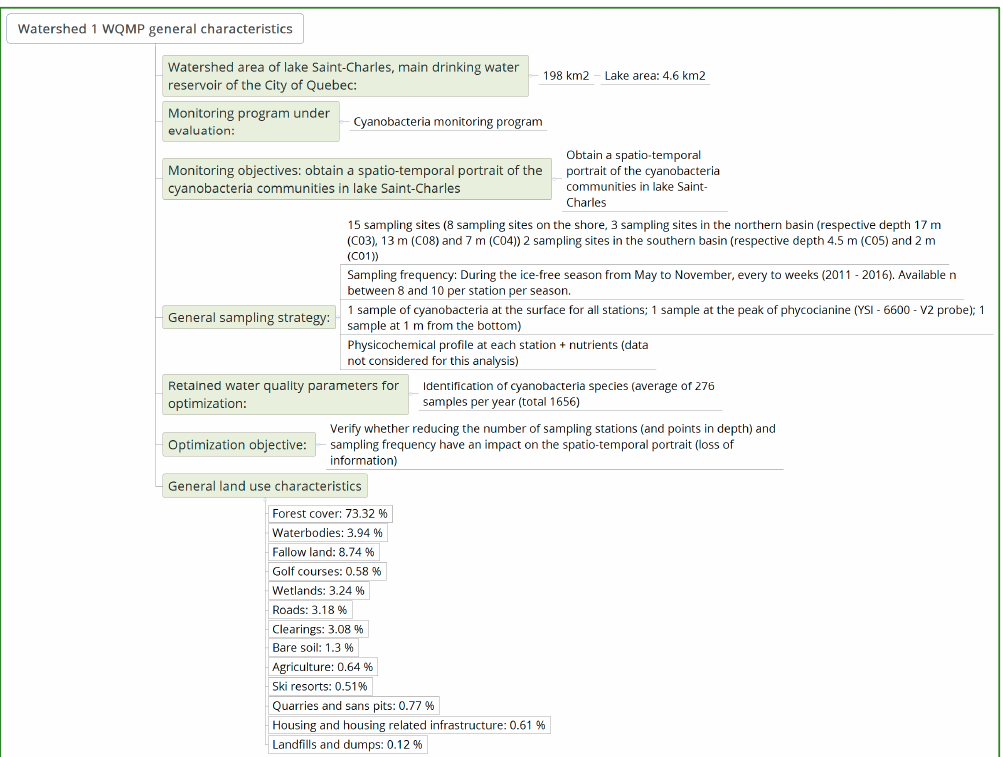
Figure 2. Outline of the Lac Saint-Charles WQMP (W1) and the optimization objective tested in this paper [21] .